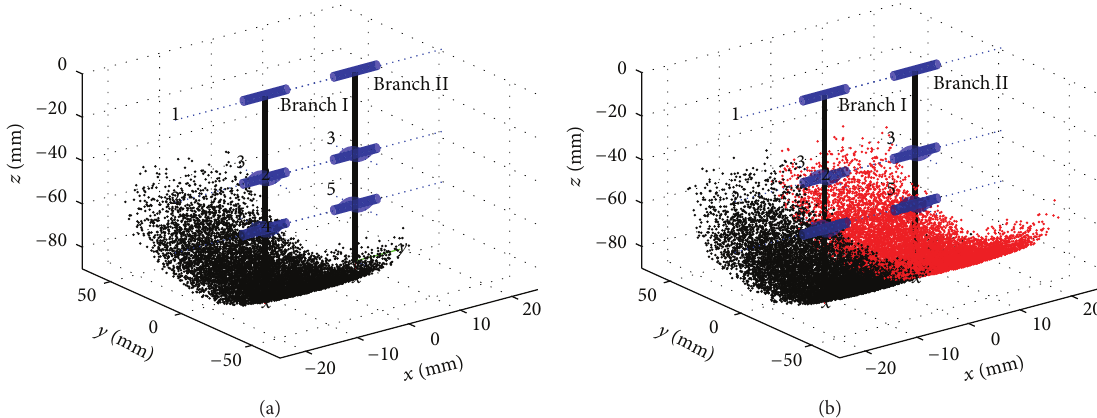
Figure 5: The available workspace of two branches with angle limitation during swing phase. The set of black points in (a) and (b) describes the workspace of branch I, while the red ones in (b) show that of branch II.